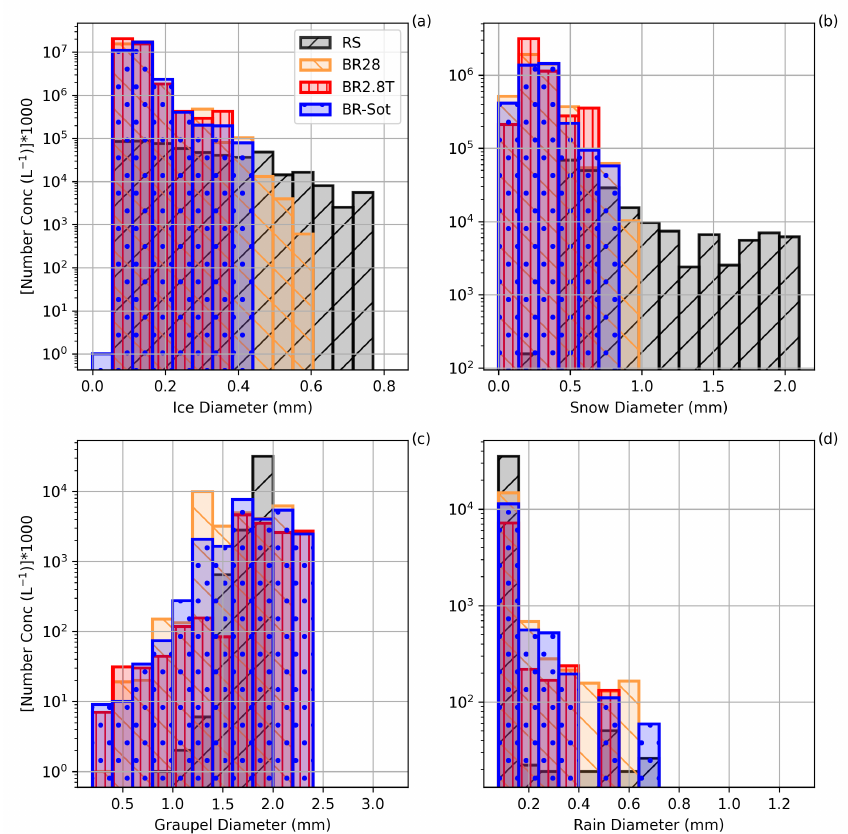
Figure 7. Particle size distribution for panels (a) ice, (b) snow, (c) graupel and (d) raindrops for all the simulations at